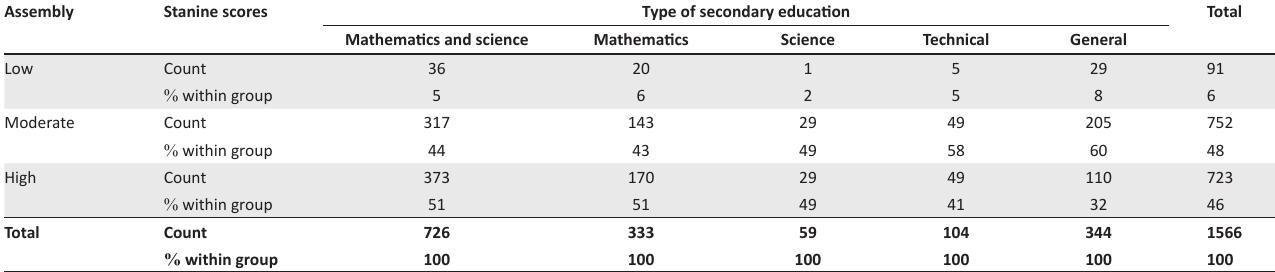
TABLE 4: Contingency table of observed frequencies for the assembly sub-test.